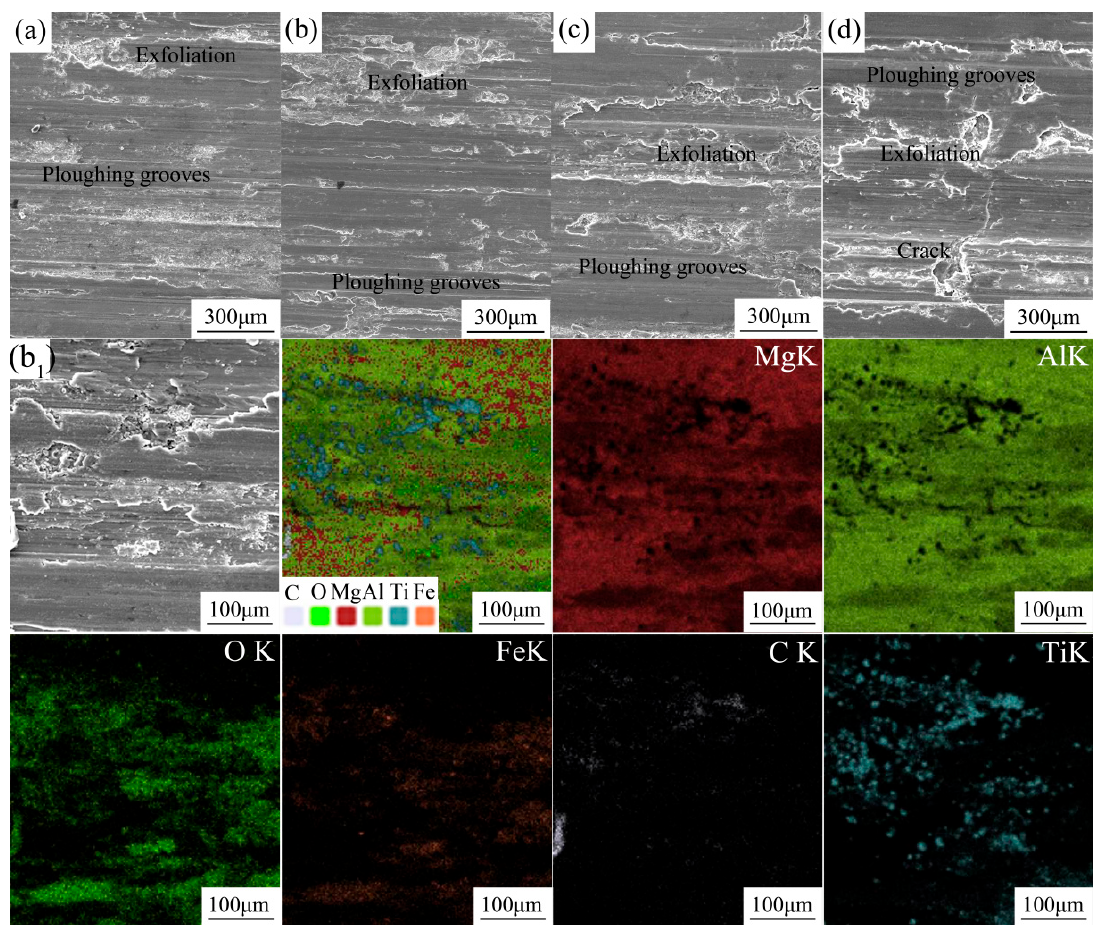
Figure 7. Worn surface morphologies of laser-fused layers: ( a ) Al+5wt%TiC; ( b ) Al+10wt%TiC; ( c ) Al+15wt%TiC; ( d ) Al+20wt%TiC. Panel ( b1 ) shows the elemental distribution on the worn surface of specimen ( b ).